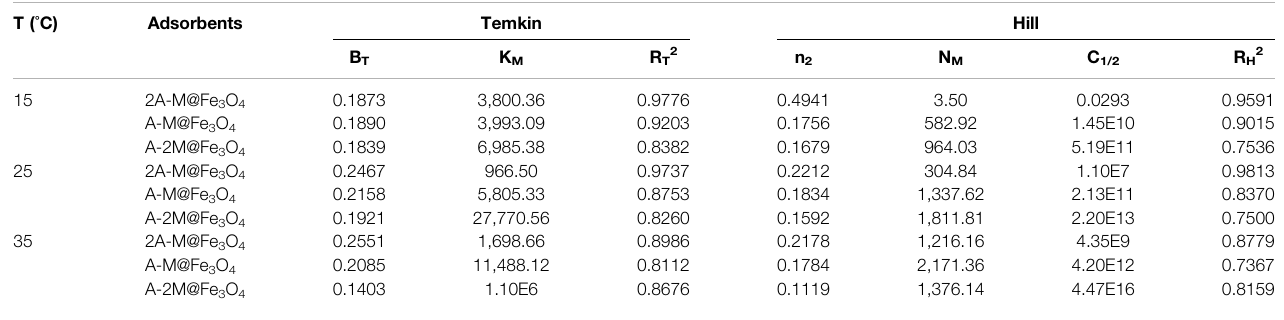
TABLE 2 | Temkin and Hill isotherm parameters of bifunctional PSQ/CNTs magnetic composites for Hg(II). T ( ° C)